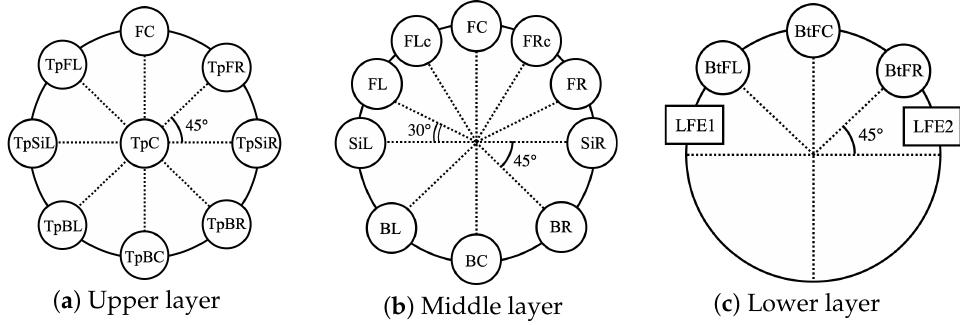
Figure 1. Loudspeaker arrangement of 22.2 multichannel audio.